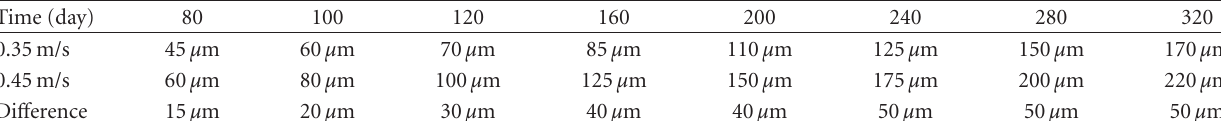
Figure 5: (a) Cross-section of a bar under axial stress showing corrosion loss, (b) cross-section of a plate under bending stress showing e ff ect of corrosion, and (c) cross-section of a plate subject to pitting from one side, σd o . Table 7: E ff ect of di ff erent water velocities on corrosion loss.